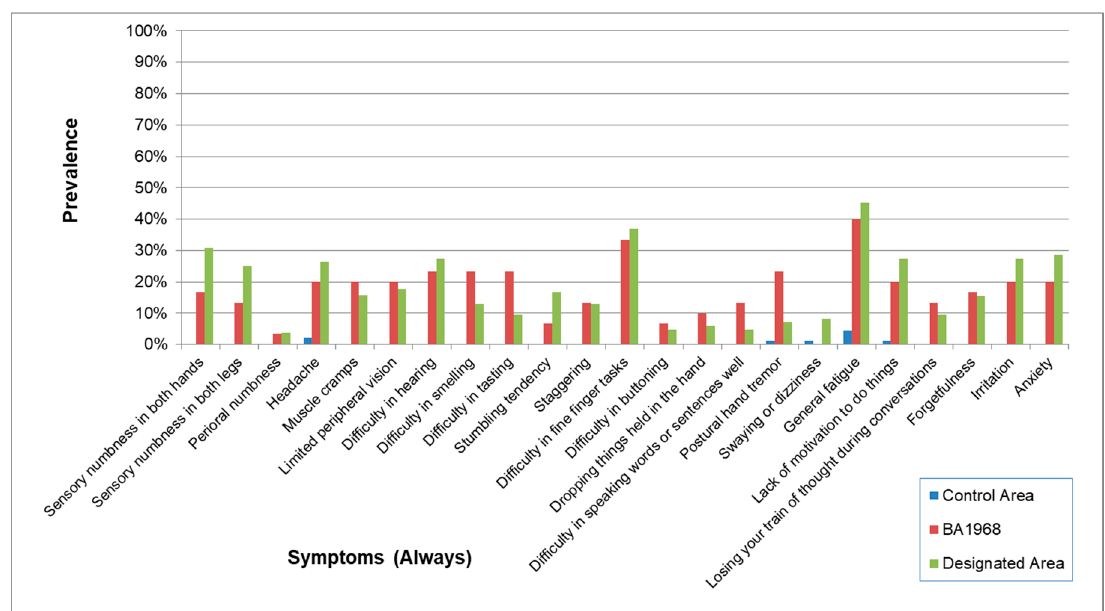
Figure 11. Prevalence of symptoms (Always) in the younger generation. Prevalence in BA1968 and the Designated Area were higher than in the Control Area. The symptomatic patterns in BA1968 and the Designated Area were similar.